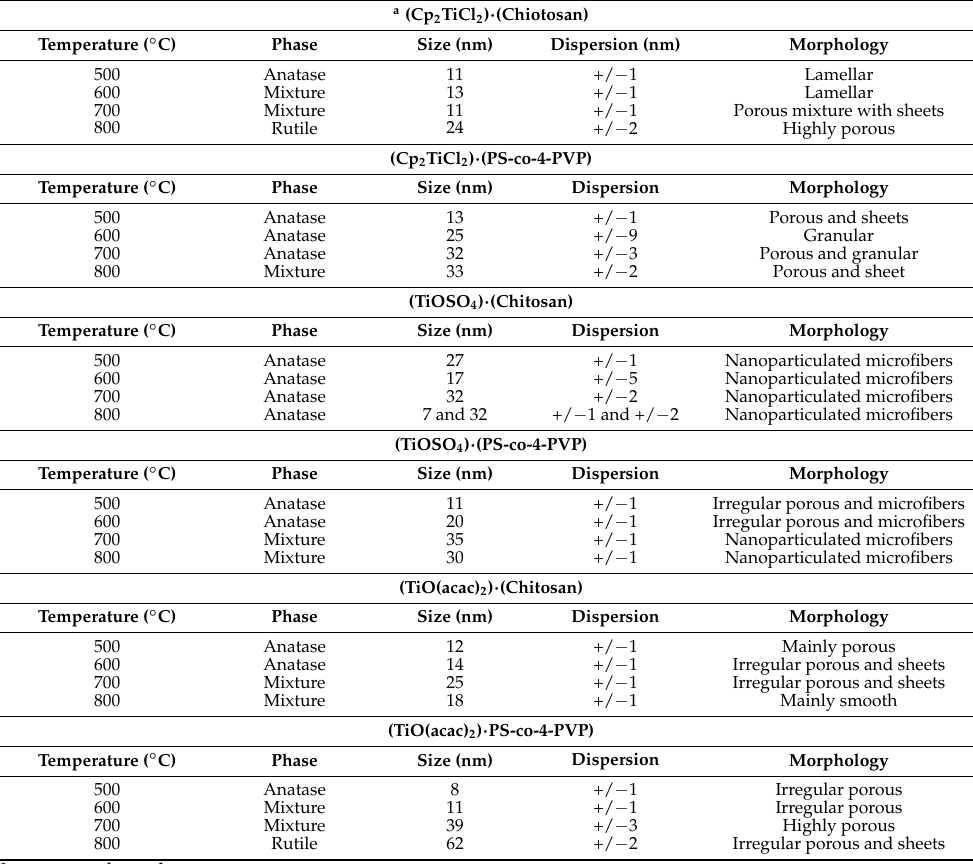
Table 1. Pyrolysis temperature, phase, particle size, and morphology for the TiO 2 obtained from the different precursors at several